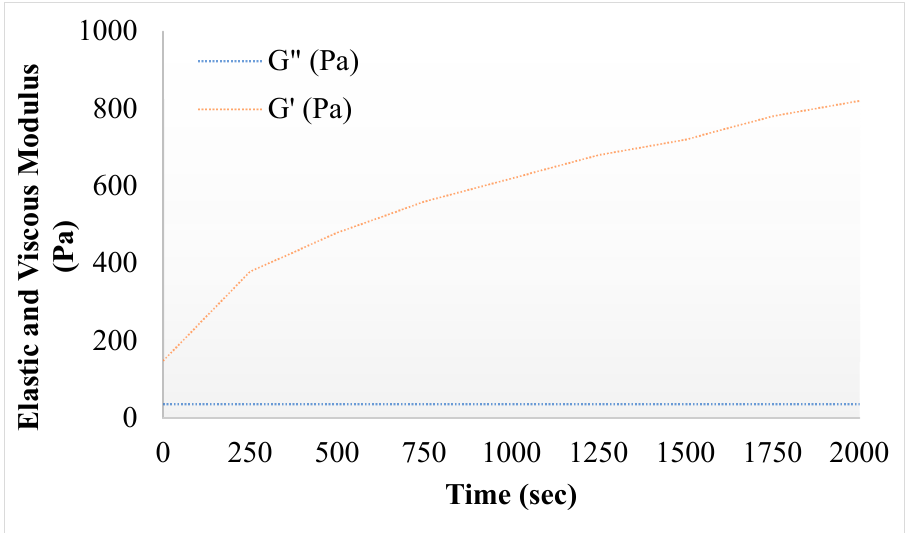
Figure 3. Elastic and viscous modulus of 5FU-Alg-Np-HG.